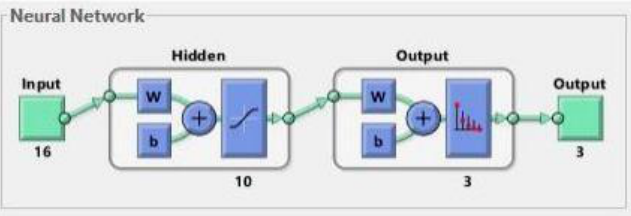
Figure 2. Neural network